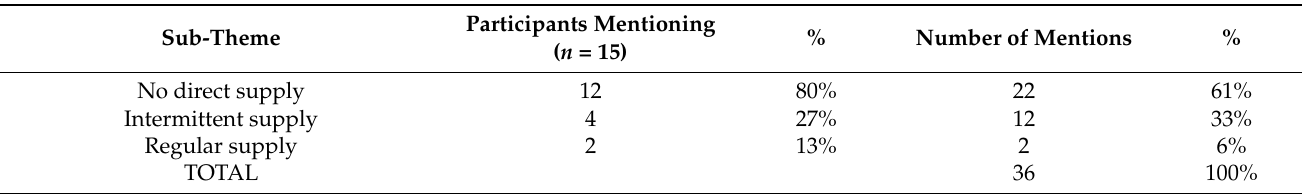
Table 6. Water supply among assisted